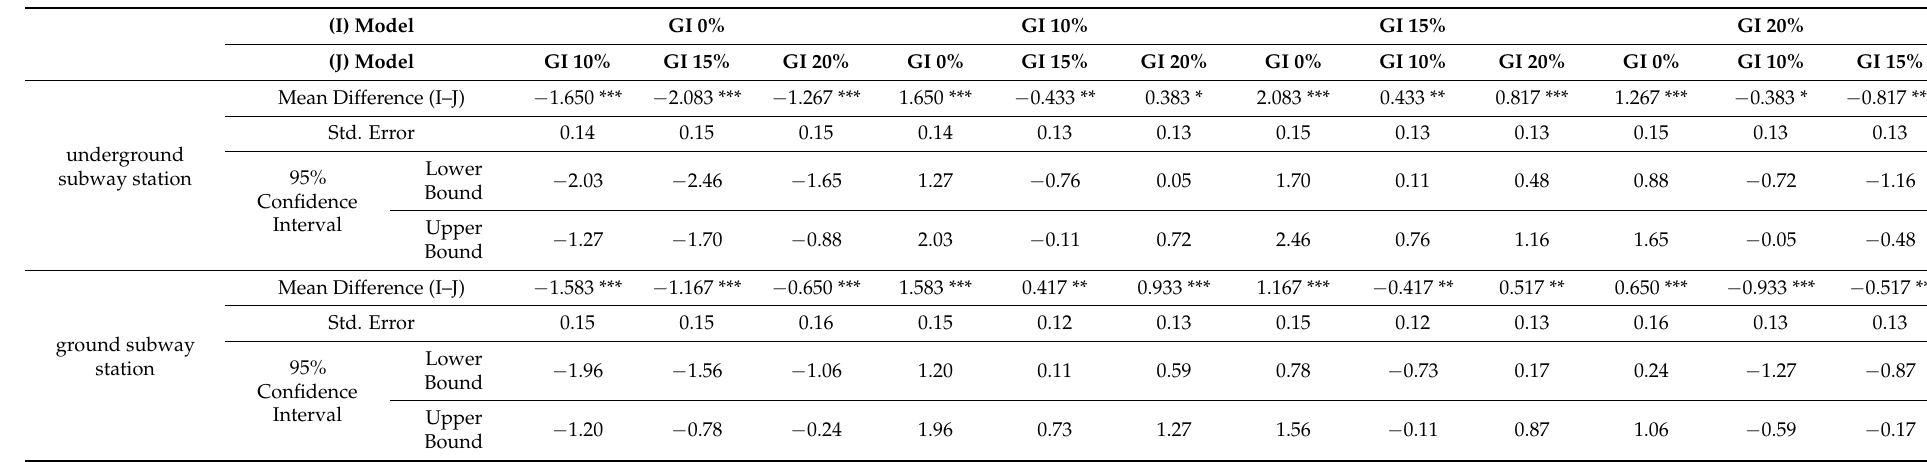
Table 6. Post-hoc Test for Interior Landscape Model